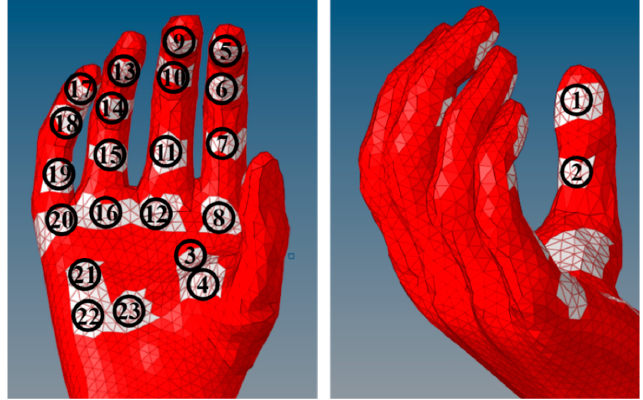
Figure 7. Regions on the hand FE model used in validation. White color denotes selected elements belonging to 23 regions.